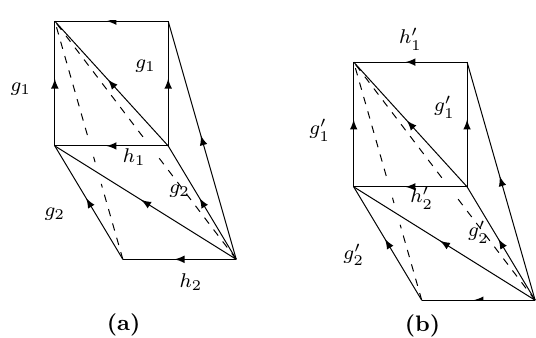
Figure 9 . (a) the multiplication coefficients β h gether. (b) The Fourier transformed factor F [ β ] ( ρ,x )( η,y )